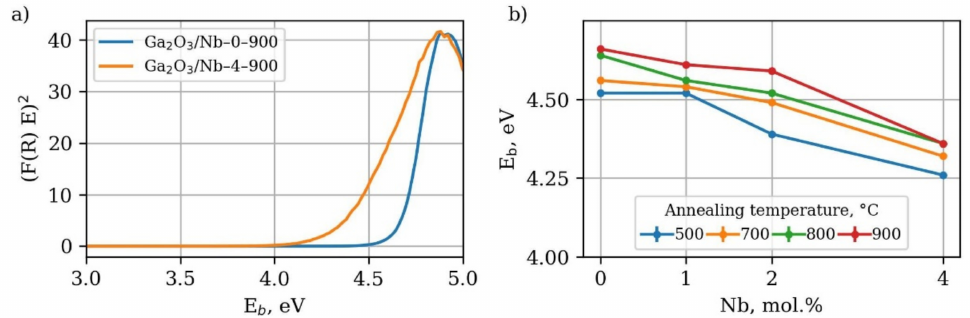
Figure 5. ( a ) Kubelka–Munk plot of optical absorption of synthesized materials ( b ) dependence of optical band gap width on Nb content and annealing